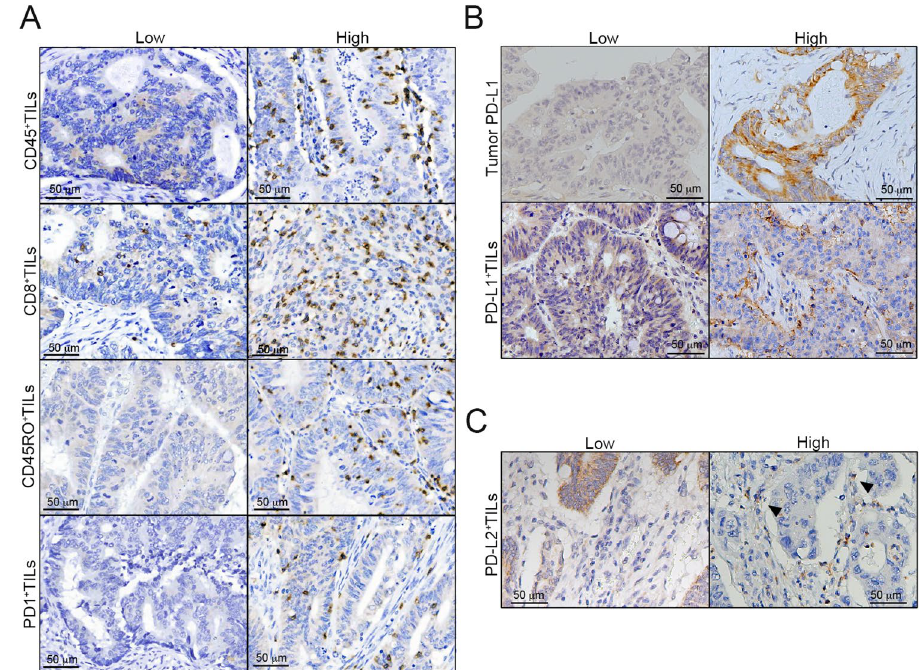
Figure 3. The representative images of immune signatures. ( A ) The intratumor infiltration of CD45 + cells (CD45 is a general lymphocyte marker), CD8 + cells (CD8 is a cytotoxic T lymphocyte marker), CD45RO + cells (CD45RO is a memory T lymphocyte marker), PD1 + cells (PD1 is an immunosuppressive lymphocyte marker) within TME. ( B ) PD-L1 expression on tumor cells and intraepithelial TILs within TME. ( C ) PD-L2 was partially expressed in intraepithelial TILs within TME. Scale bar = 50 μm.